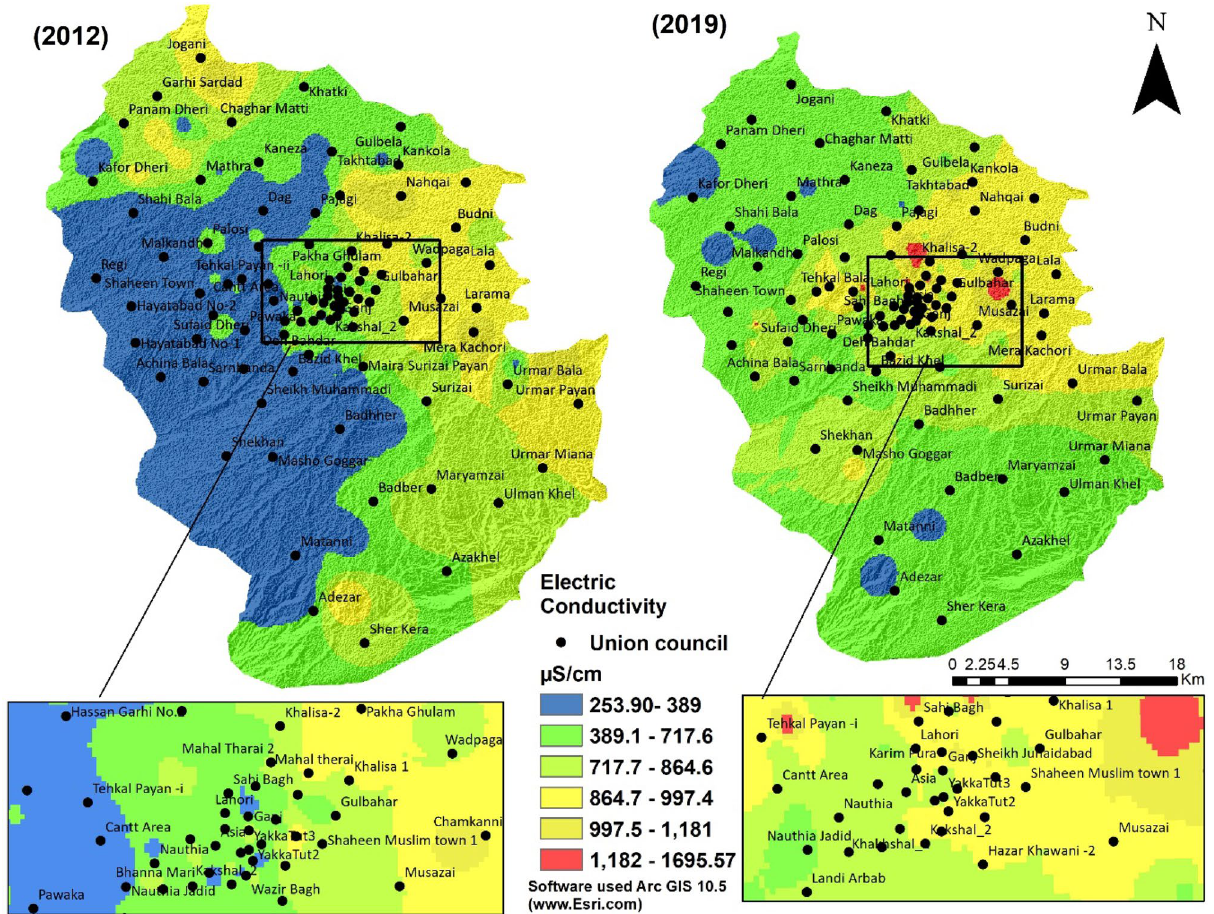
Figure 4. Electric conductivity of groundwater in the periods of 2012 and